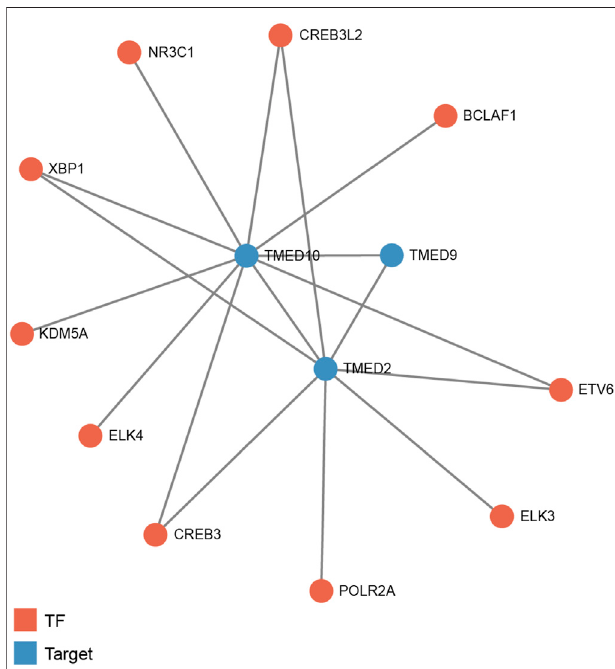
FIGURE 9 | Predicted potential upstream regulatory transcription factors of TMED2/9/10 in HNSC based on Gene Regulatory Network database (GRNdb). TF: transcription